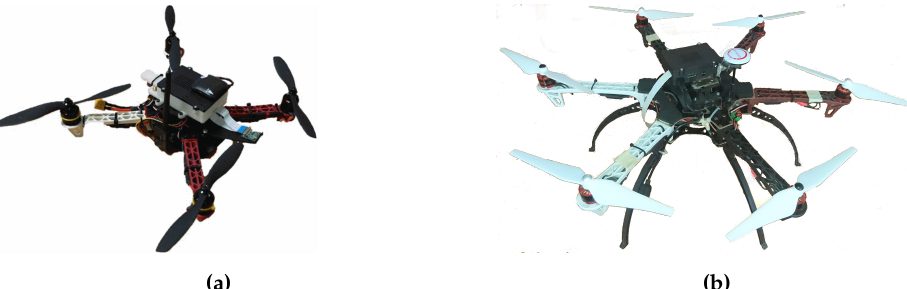
Figure 12. Multicopters used in real testbed. ( a ) Quadcopter, and ( b ) hexacopter.